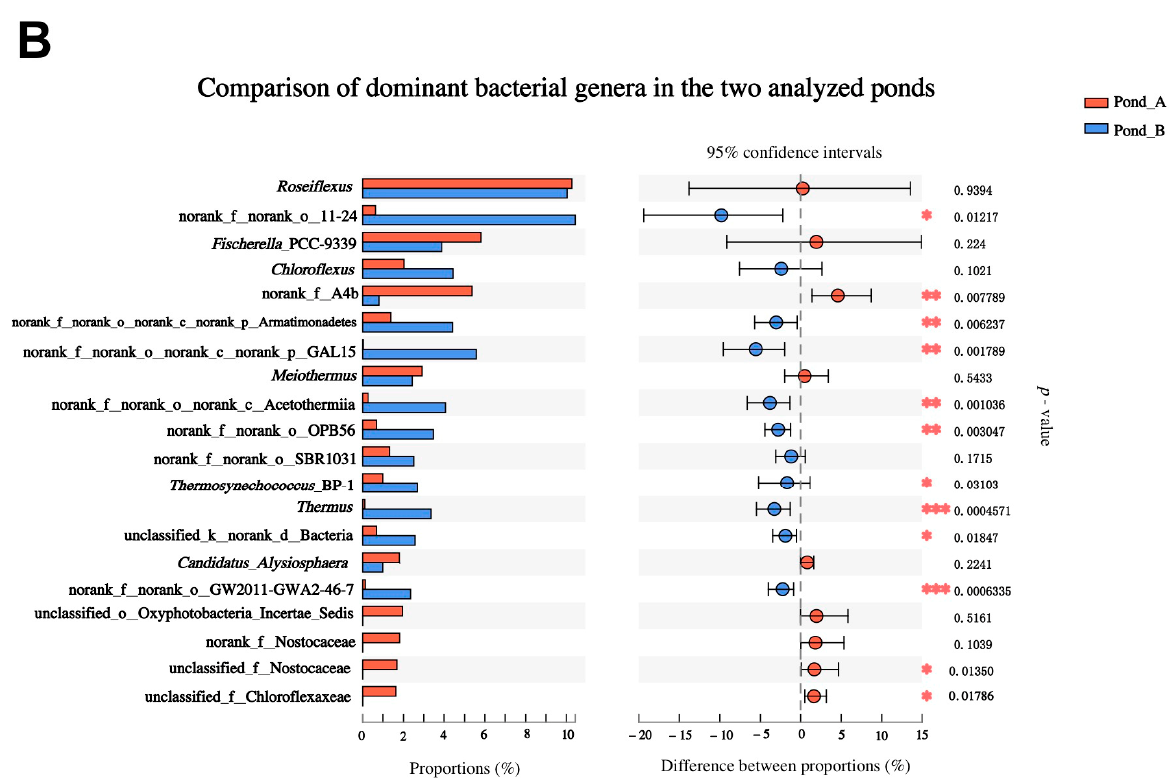
Figure 7. Comparison of the dominant genera of fungal ( A ) and bacterial ( B ) communities in the two analyzed ponds. Differences in the genera between both ponds as evaluated by Wilcoxon rank-sum test is indicated as: * p < 0.05, ** p < 0.01, *** p < 0.001. In the taxa names, “d” = domain, “k” = kingdom, “p” = phylum, “c” = class, “o” = order, and “f” = family. Principal coordinate analysis revealed clustering of fungal and bacterial OTUs based on sampling locations (Pond A and Pond B) using weighted Unifrac distance (Figure 8), which was consistent with the heatmap results of sample clustering.